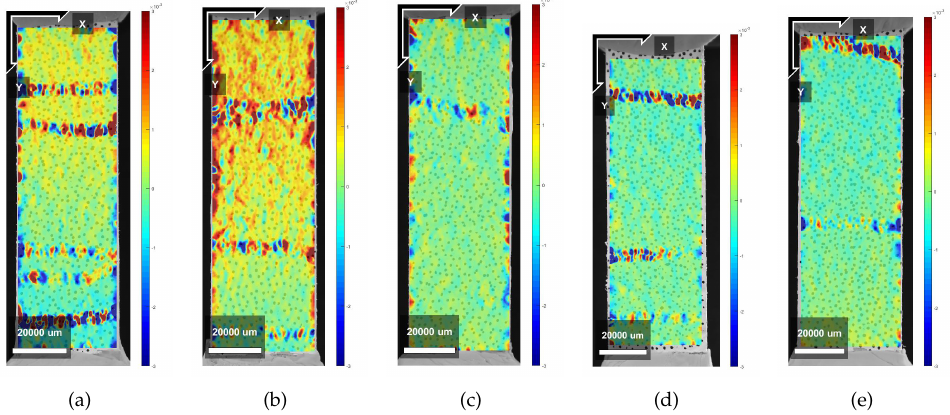
Figure 8. Crack pattern obtained from DIC analysis on X samples—Horizontal Deformations.